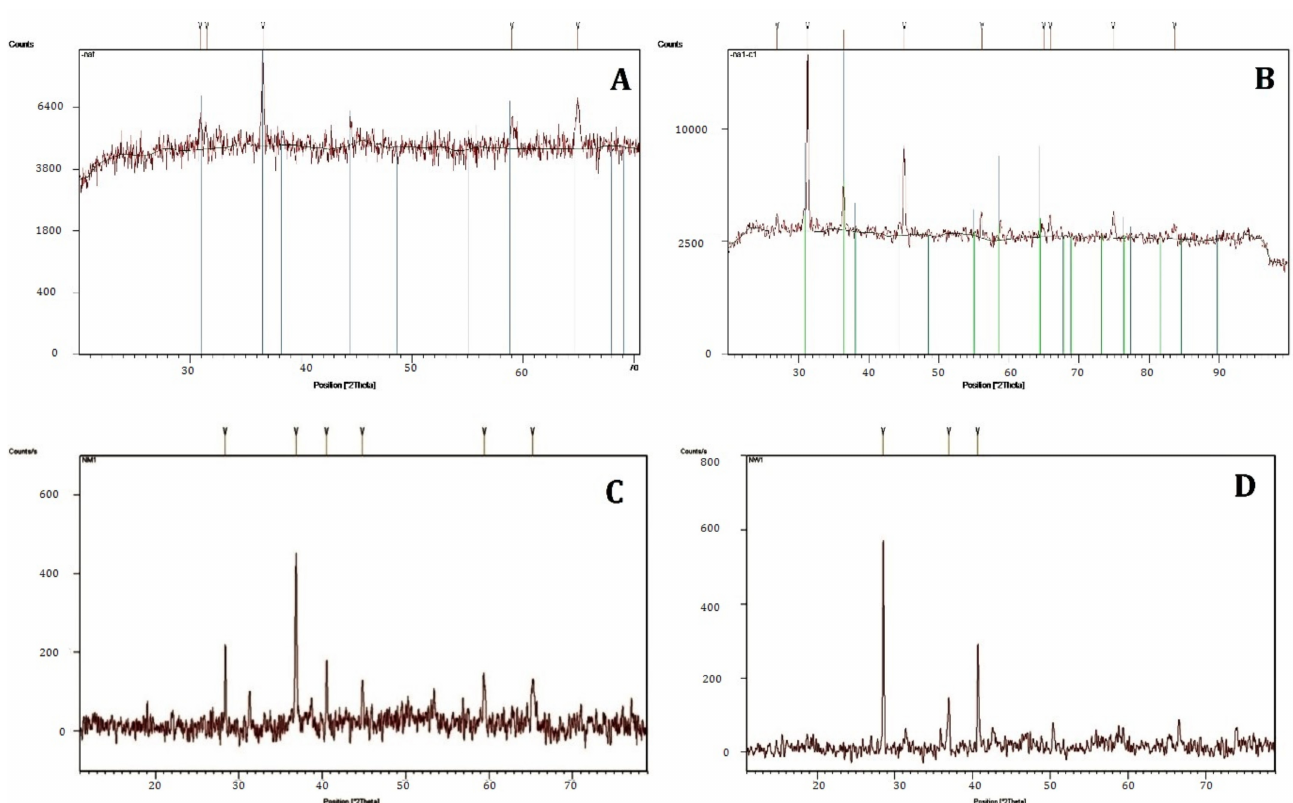
Figure 2. ( A – D ): X-ray diffraction spectroscopy (XRD) pattern of cobalt oxide synthesized from Fusarium oxysporum ( A ), bacterial strain N1C1 ( B ), aerial parts of Aerva javanica ( C ), and water extract of dried aerial parts Aerva javanica ( D